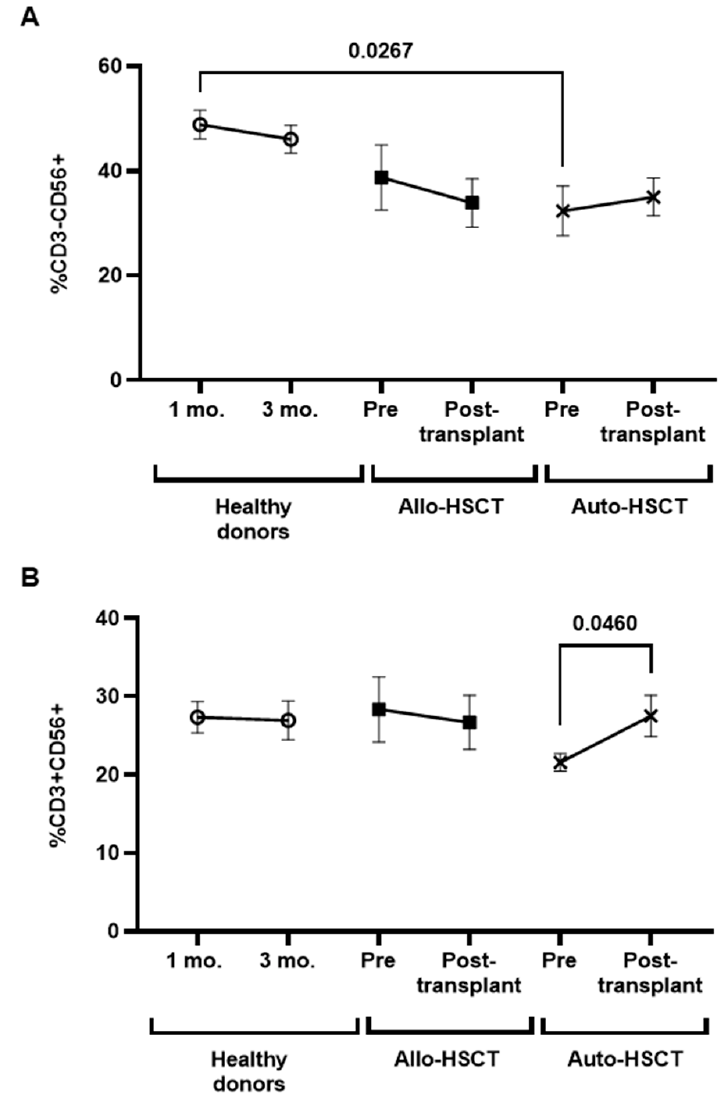
Figure 6. Characterization of NK and NKT-like cells in PBMCs from individuals with OHD before and after receiving Allo- or Auto-HSCT. Levels of NK (CD3-CD56+) ( A ) and NKT-like (CD3+CD56+) ( B ) cells in PBMCs from individuals with Allo- or Auto-HSCT were evaluated by flow cytometry in comparison with healthy donors. Each dot in the graphs corresponds to mean ± SEM. Different cohorts are marked with the following symbols: Healthy donors (white circles), Allo-HSCT (black squares), and Auto-HSCT (cross). Statistical significance between groups was calculated using a one-way ANOVA test, and statistical significance within groups was calculated using a t-test.